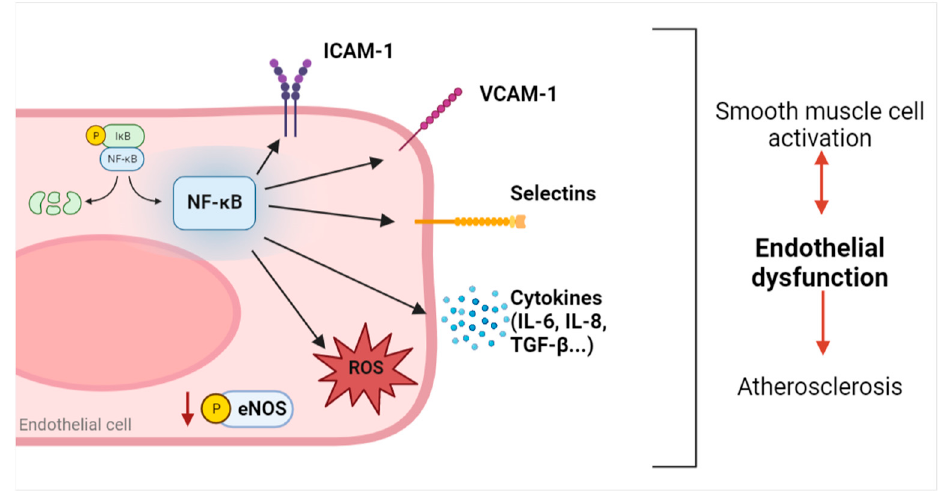
Figure 2. Schematic overview of the NF-kB pathway and angiocrine factors activated in endothelial dysfunction. NF-kB activation induces the upregulation of pro-inflammatory factors (ICAM-1, VCAM-1, selectins, and cytokines) and an increase in intracellular ROS. All these angiocrine factors, in combination with reduced eNOS phosphorylation, contribute to the exacerbation of endothelial dysfunction and smooth muscle cell activation, enhancing the atherosclerotic burden. ICAM-1: intracellular adhesion molecule 1; VCAM-1: vascular cell adhesion molecule 1; IL: interleukin; TGF- β : transforming growth factor β ; ROS: reactive oxygen species; eNOS: endothelial nitric oxide synthase. Image created with Biorender.com.